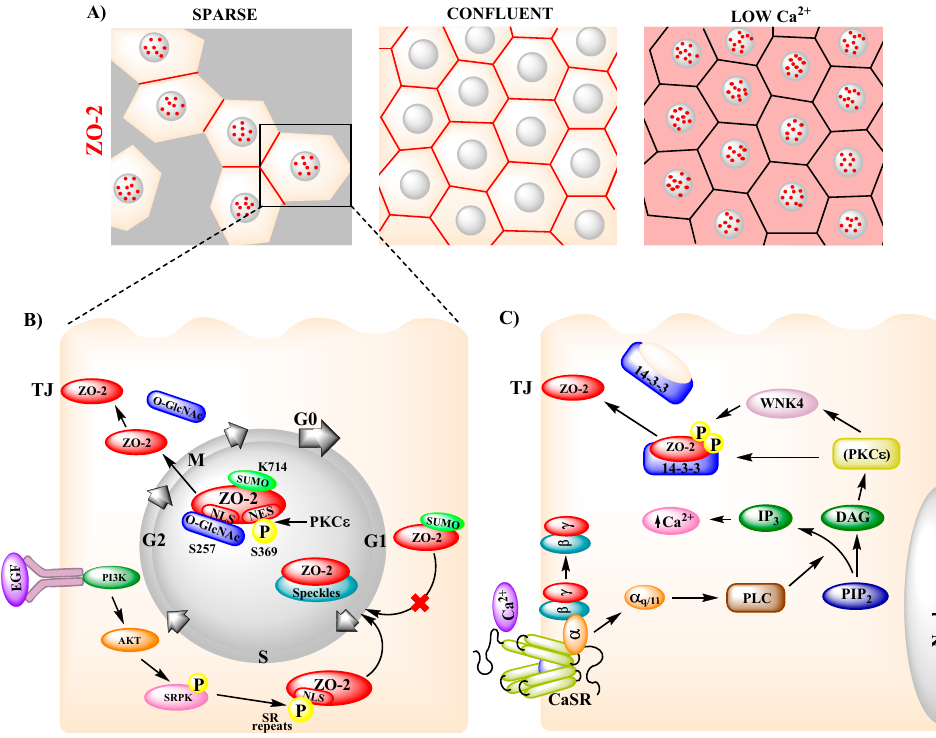
Figure 2. Intracellular movement of ZO-2. ( A ) In sparse cultures, ZO-2 is present in nuclear speckles (red dots) and TJs (red cell borders), whereas in confluent cells ZO-2 concentrates at TJs (red cell borders). In cells cultured with low Ca 2+ (1–5 µM) ZO-2 distributes diffusely in the cytoplasm (pink cytoplasmic staining) and concentrates in nuclear speckles (red dots). ( B ) In sparse cultures, epidermal growth factor (EGF) induces AKT activation, which triggers ZO-2 phosphorylation of serine-arginine (SR) repeats by SR protein kinase (SRPK). Nuclear localization signals (NLSs) of ZO-2 and phosphorylated SR repeats induce the arrival of ZO-2 to nuclear speckles at late G1. ZO-2 exit from the nucleus requires the phosphorylation of Ser369 within a nuclear exportation signal (NES) by PKC ԑ and the inactivation of bpNLS-2 by O -GlcNAc of Ser257, and is facilitated by SUMOylation of Lys714. ( C ) Extracellular Ca 2+ activates the Ca 2+ -sensing receptor (CaSR) present in the plasma membrane that signals through the G α q/11 subunit, activating PLC, which hydrolyzes PIP2 into DAG and IP3. DAG activates PKC ԑ , leading to ZO-2 phosphorylation by WNK4. This phosphorylation induces the disassembly of ZO-2 from 14-3-3 proteins in the cytoplasm and triggers the relocation of ZO-2 to the plasma